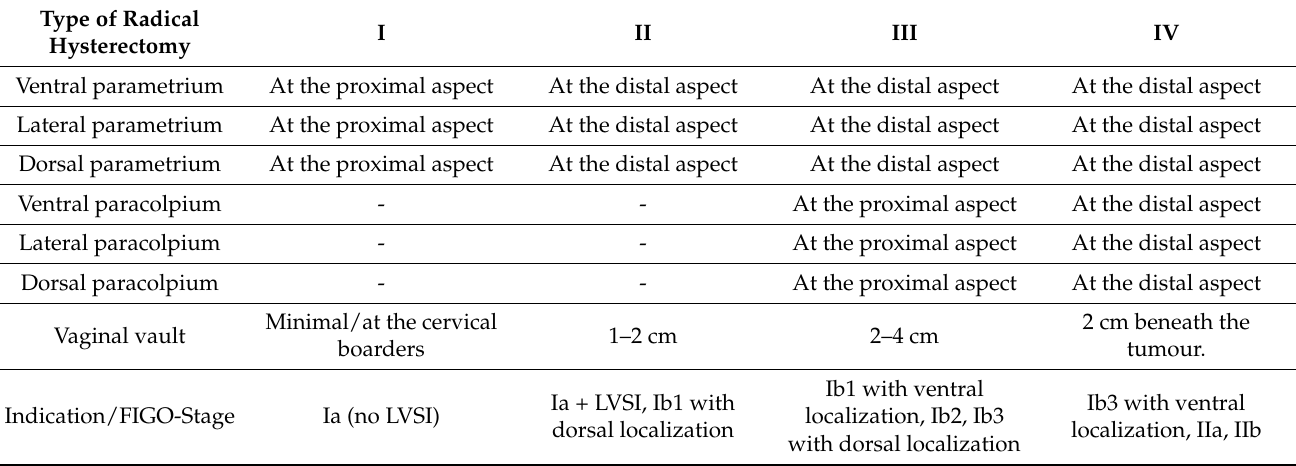
Figure 10. The graphic explanation of all types of a new classification of radical hysterectomy. Table 2 explains the types of radical hysterectomy according to this new classification. Table 2. Types of radical hysterectomy in Muallem classification with the clinical indication and the expected length of the resected vaginal